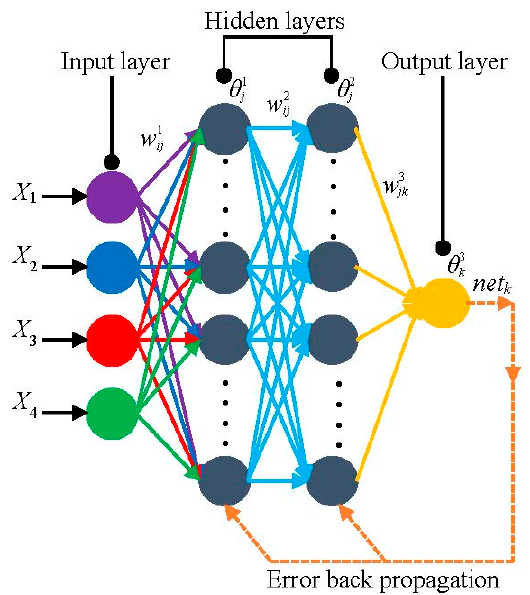
Figure 4. The structure of BPNN.